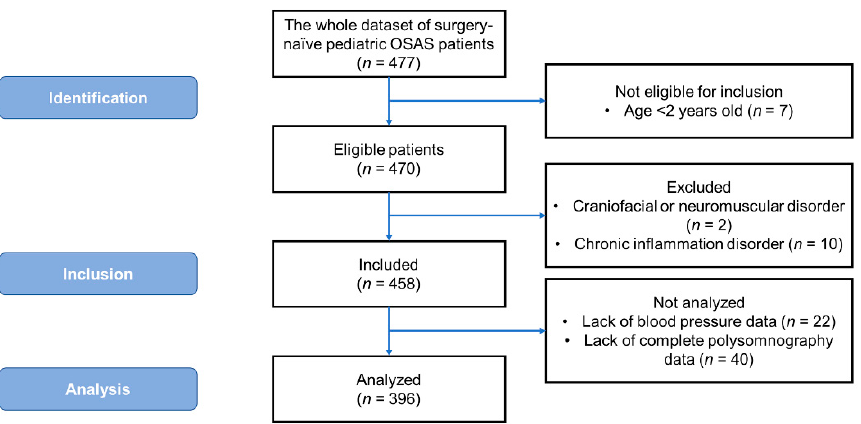
Figure 1. The Strengthening the Reporting of Observational Studies in Epidemiology (STROBE) [23] flow diagram of the study participants. Abbreviation: OSAS: obstructive sleep apnea syndrome.